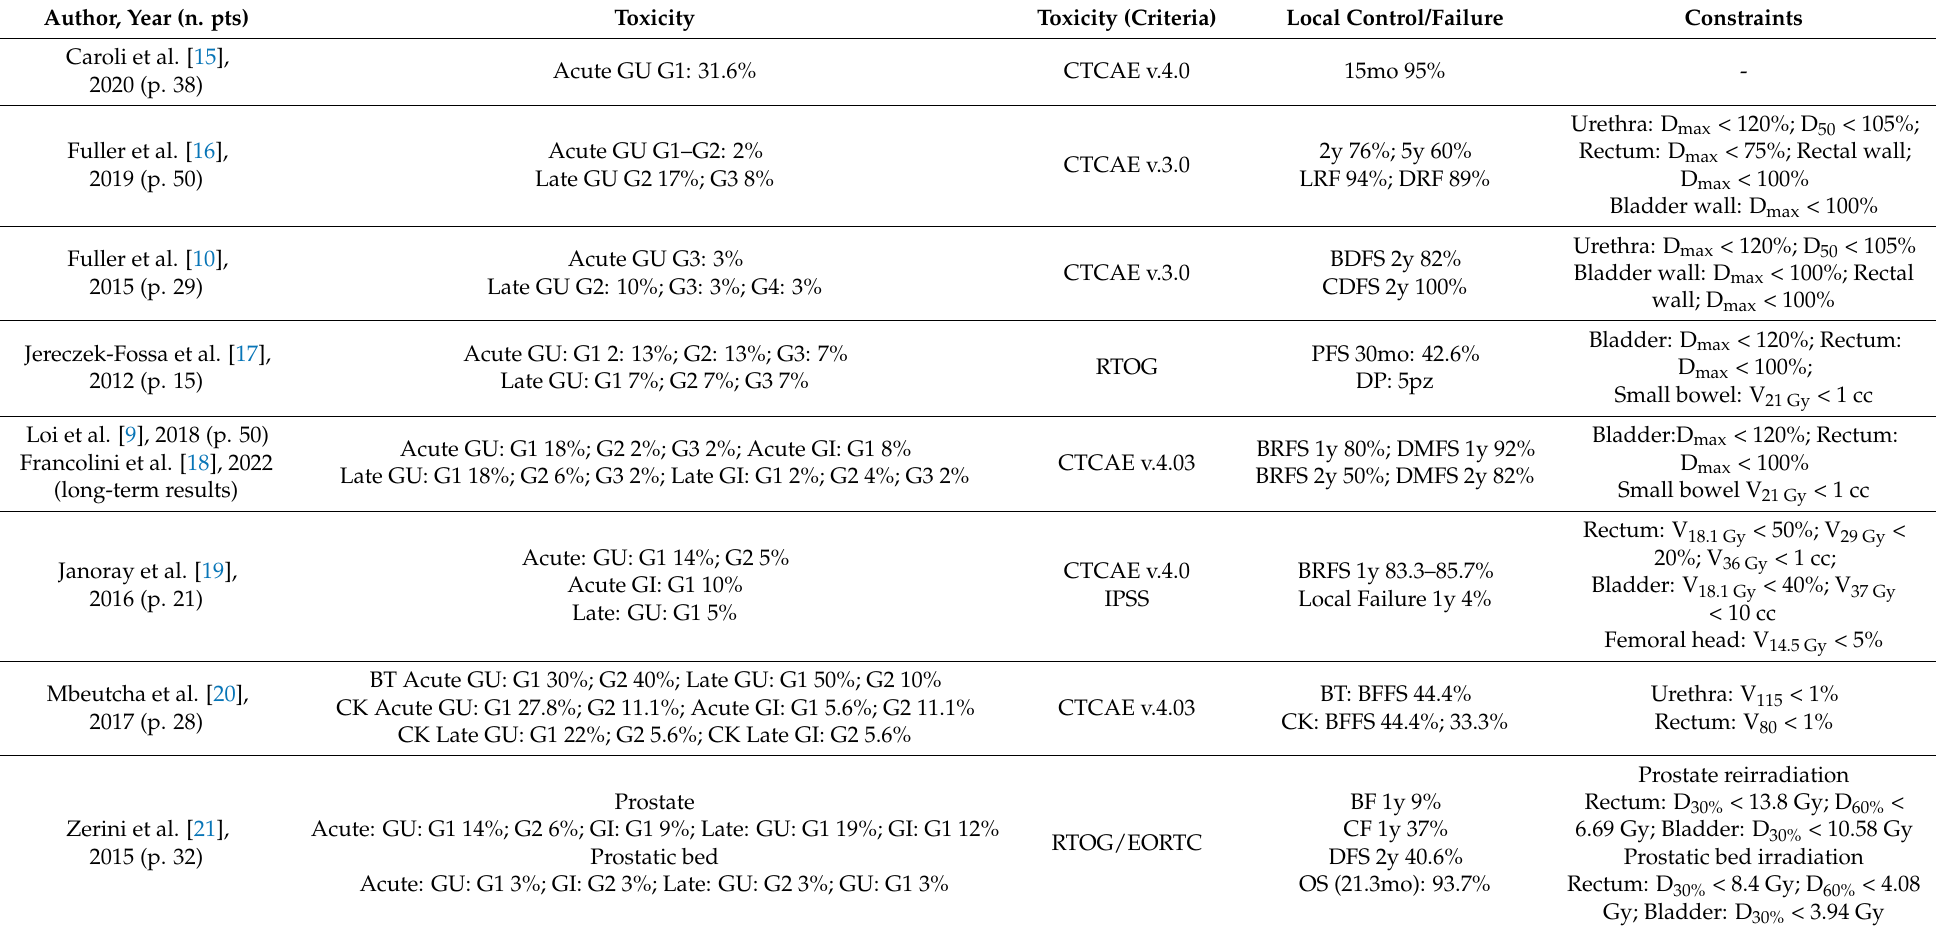
Table 7. Literature search: toxicity, local control/failure, and